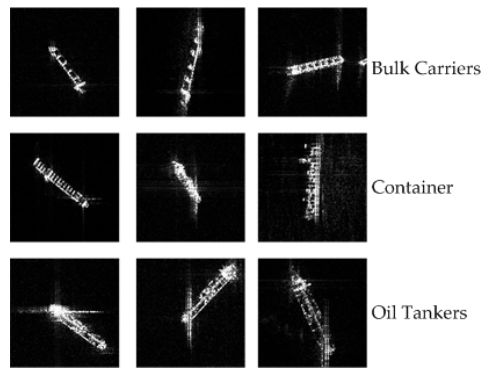
Figure 7. Examples of ship chips. Table 1. Experimental SAR images information.